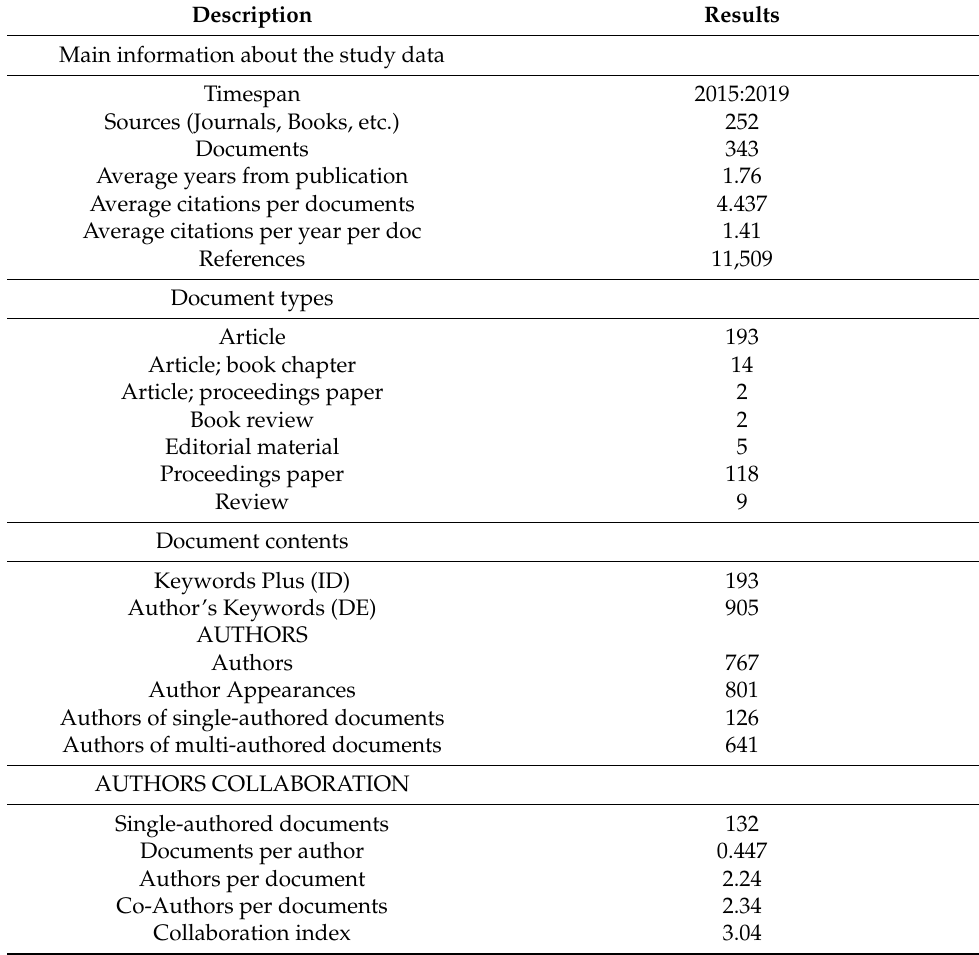
Table 2. Main information about the study